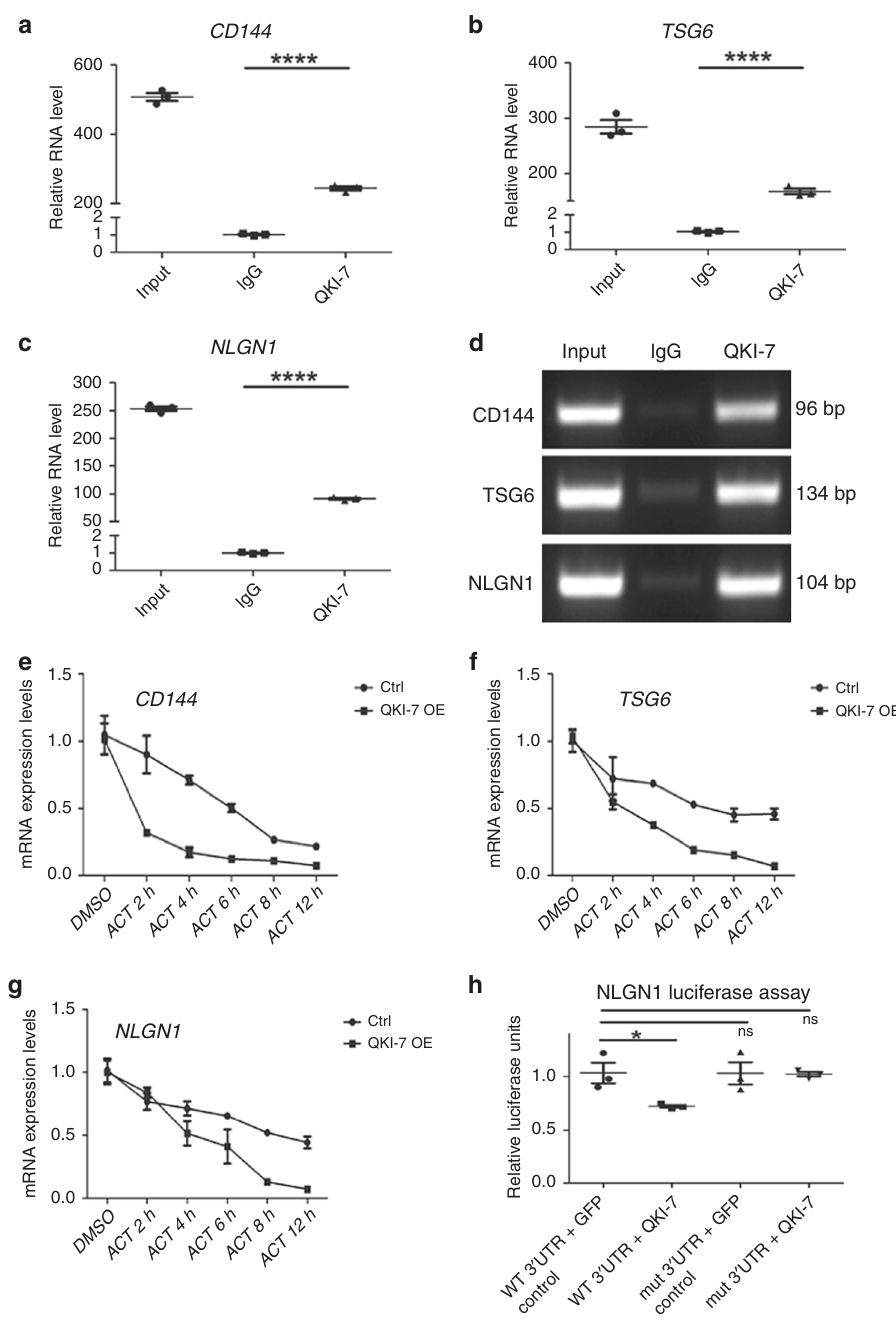
Fig. 5 QKI-7 promoted degradation of CD144, NLGN1, and TSG6 mRNAs. RNA immunoprecipitation (RIP) was carried out on P014 hiPS-ECs. Signi fi cantly more RNAs of CD144, TSG6, and NLGN1 were precipitated by QKI-7 antibody shown by real-time PCR and conventional PCR, indicating the direct binding of QKI-7 to transcripts of these three RNA targets ( p values: <0.0001) ( a – d ). When QKI-7 overexpressing hiPS-ECs or control cells (hiPS- ECs overexpressing an empty vector) were treated with actinomycin D in time point experiments from 0 to 12 h, the QKI-7 overexpression group showed lower mRNA level of CD144, TSG6, and NLGN1 at most of the time points as shown by the mRNA-decay curve, indicating that ectopic QKI-7 promoted mRNA degradation of the three targets ( e – g ). QKI-7 co-transfection with luciferase reporter plasmid containing wild-type 3 ′ UTR of NLGN1 signi fi cantly suppressed the luciferase activity ( p value: 0.0329). While this effect was unobservable when QKI-7 was co-transfected with luciferase reporter plasmid containing mutated 3 ′ UTR NLGN1 for the QKI motif ( h ). Data are from three biologically independent experiments. Error bars represent mean ± SEM ( n = 3). P values are shown: * p < 0.05, **** p < 0.0001, ns: not signi fi cant (two-tailed t test). Source data are provided as a Source data fi